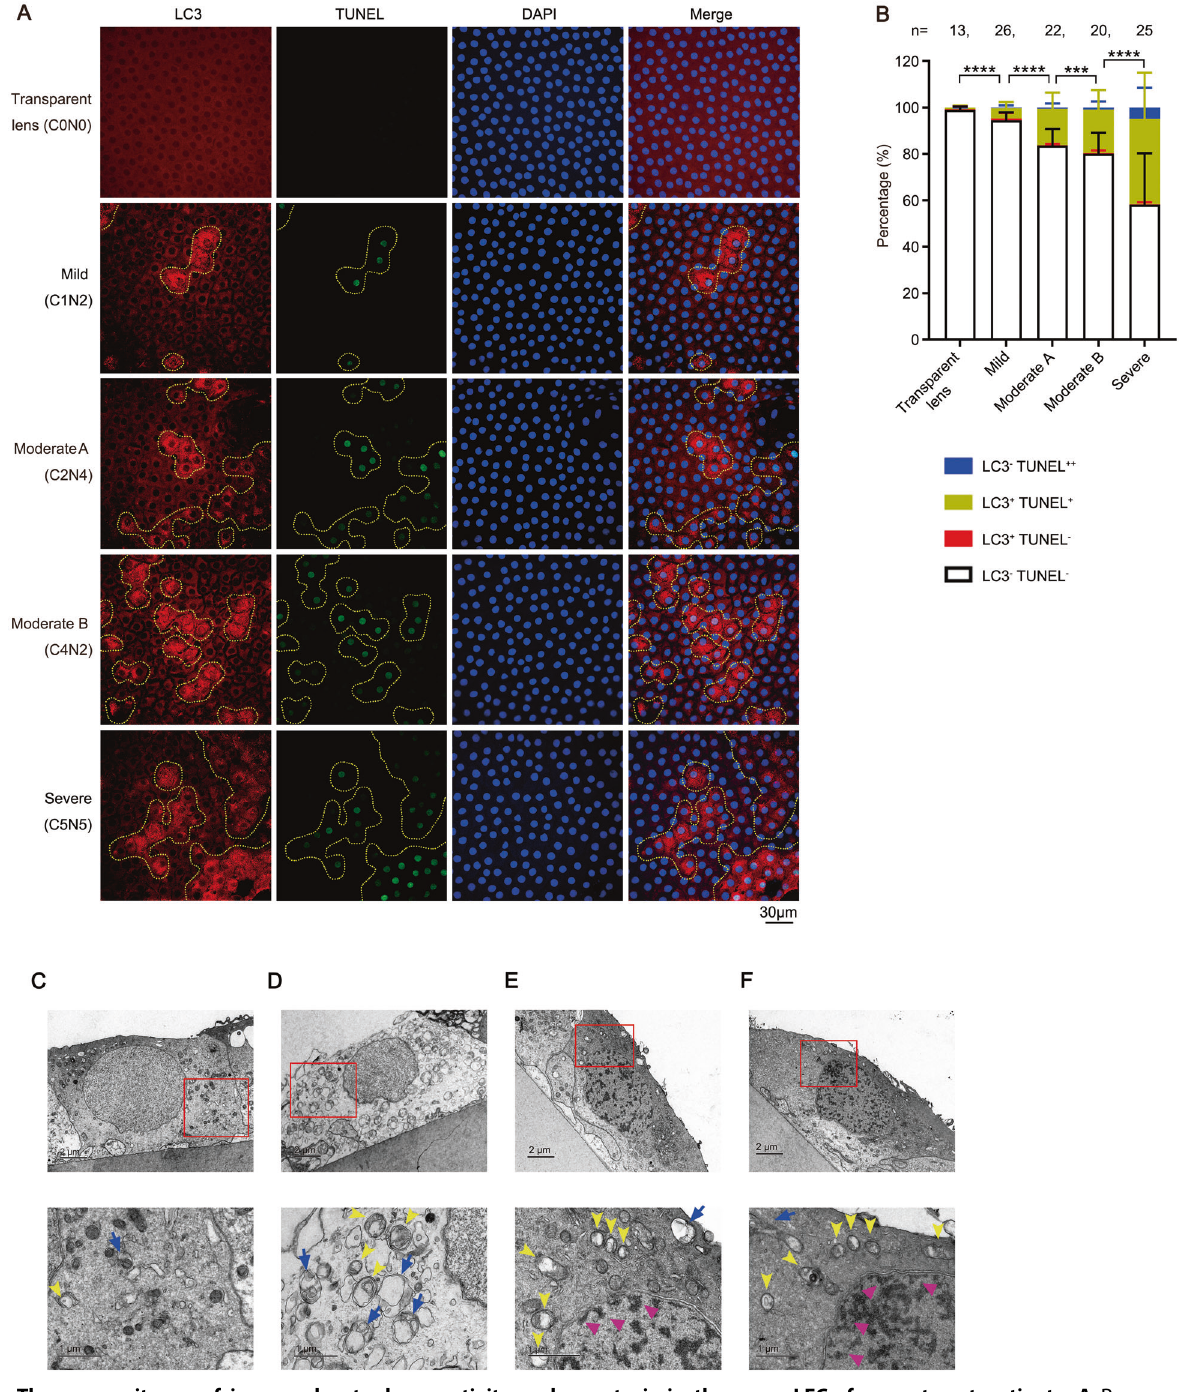
Fig. 1 The concomitance of increased autophagy activity and apoptosis in the same LECs from cataract patients. A Representative confocal images of LECs from 93 patients with different grade senile cataract and control LECs from 13 patients with a transparent lens. LECs are stained with LC3 antibody (autophagosome, red), TUNEL labeling (DNA fragment, green), and DAPI (nucleus, blue). Yellow dotted irregular circles indicate cells with LC3 puncta. Scale bar, 30 μ m. B Grouped stacked bars denoting the percentages of LC3 - TUNEL - , LC3 + TUNEL - , LC3 + TUNEL + and LC3 - TUNEL ++ LECs in lens capsules from patients as shown in A . Bars represent mean ± SD. n shows the numbers of patients analyzed. *** p < 0.001, **** p < 0.0001 ( χ 2 test followed by Bonferroni post hoc test). C – F Representative electron microscopic images of LECs from ten patients with moderate to severe senile cataract (lower panels, expanded view of the red line boxed areas in upper panel; yellow arrowheads, autophagosomes with double membranes; blue arrows, autophagolysosomes with single membrane; magenta triangles, condensed and edged